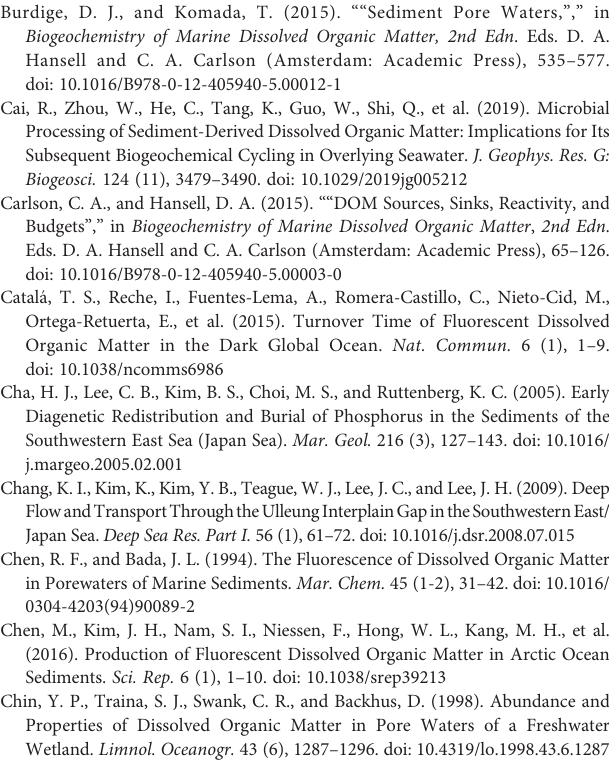
Supplementary Figure 1 | Vertical distribution of temperature (T), salinity (S), dissolved oxygen (DO) and turbidity measured by beam attenuation (B). Note that the DO concentrations in the pro fi le represent instrumental readings that were not corrected with the concentration measured by the Winkler titration method. Nonetheless, contrasting patterns showing a steep decrease and increase in DO and turbidity, respectively, are still evident in the bottom water column. Supplementary Figure 2 | Scatterplots of FDOM H fl uorescence against apparent oxygen utilization (AOU) at the slope site (KU04 and KU06) and basin site